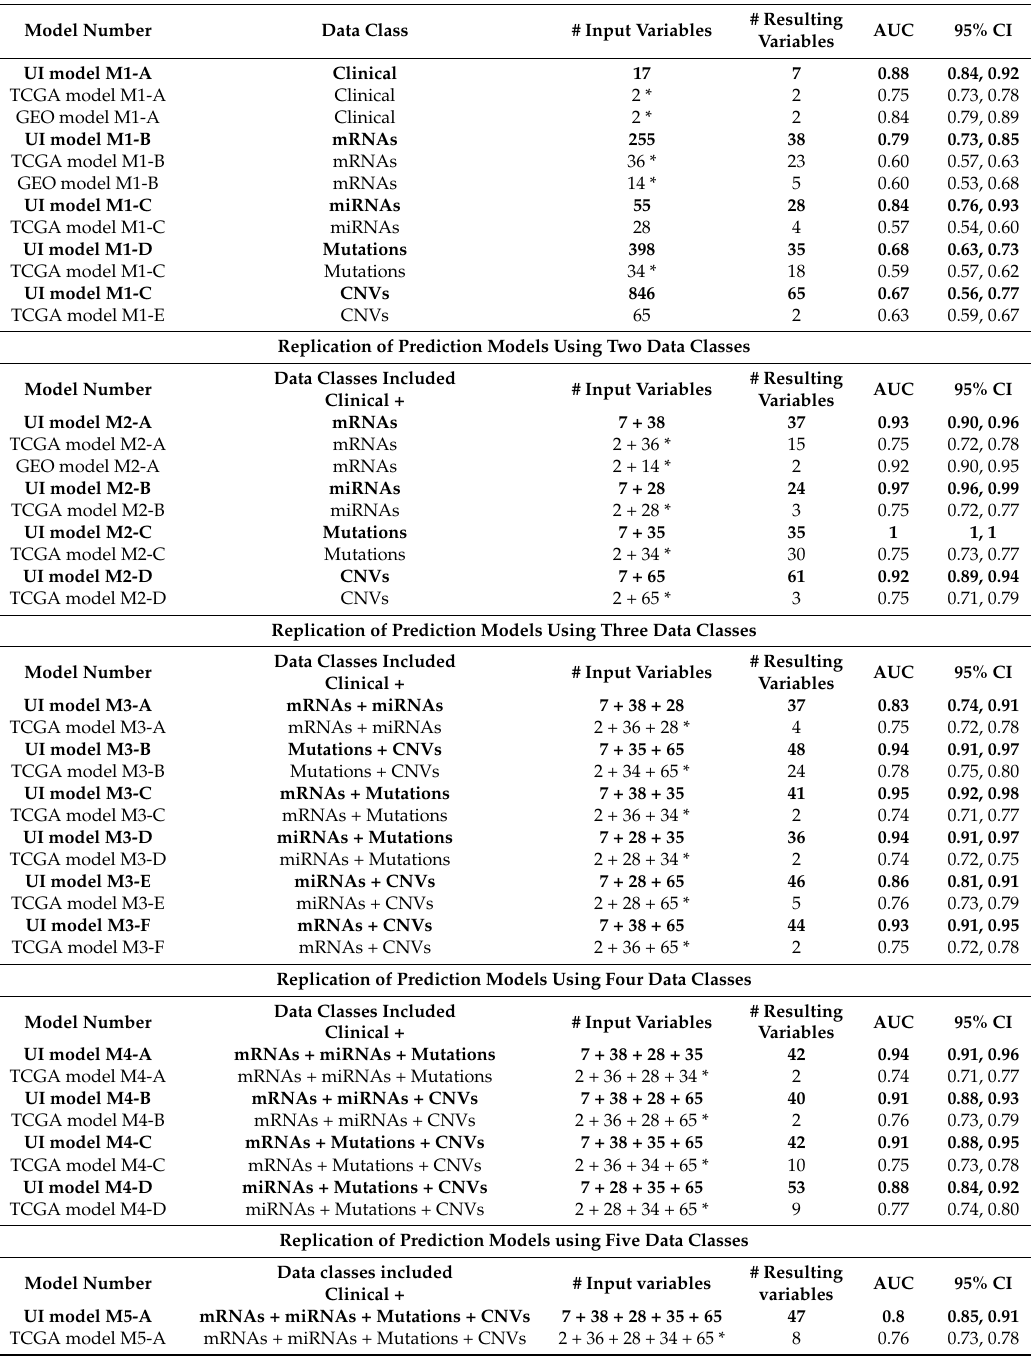
Table 3. External replication of prediction models for levels of risk. In the analysis of TCGA and GEO datasets, we used resulting variables from UI analyses of 1 data class or type; these results are included for comparison in this table and denoted as “UI model #”) (The definitions for input variables and resulting variables are the same as in Table 2). In most cases, variables resulting from the UI analyses were not available in external sets (marked by *). Model performances were measured by AUC and their 95% confidence interval